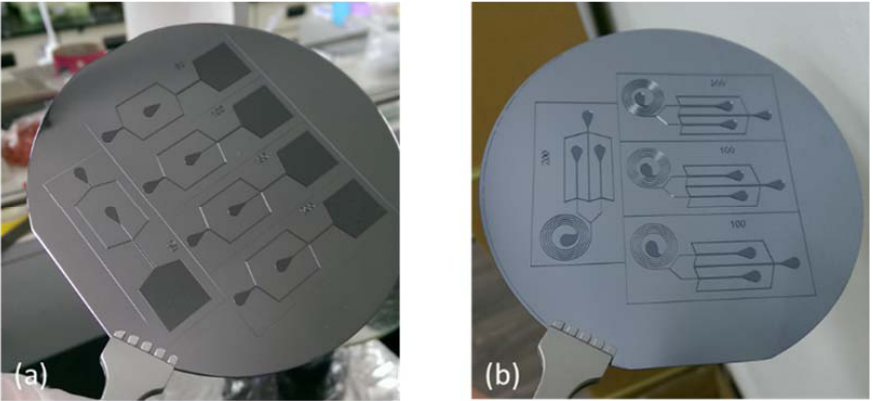
Figure 5. The finished molds for a microfluidic device: ( a ) Design from Figure 2; ( b ) Design from Figure 3.